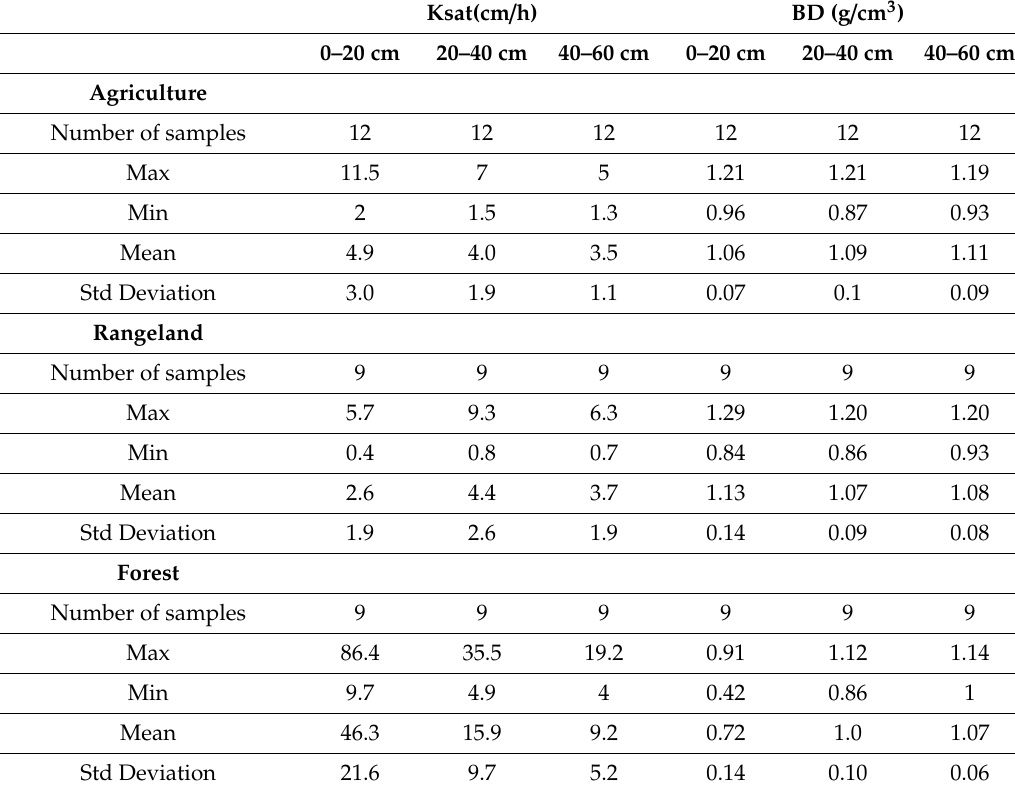
Table 8. Characteristics of hydraulic conductivity and bulk density of Kakia and Esamburmbur sub-catchments.